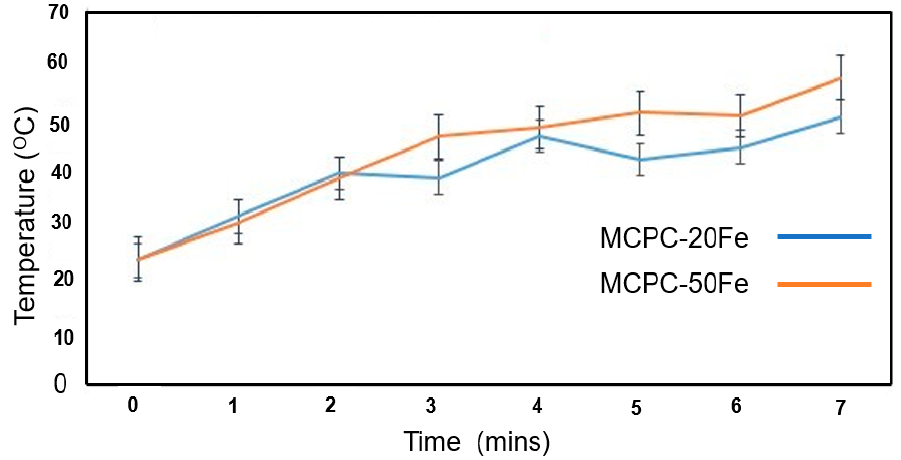
Figure 2. Heat generation profile of MCPC with different concentrations of magnetite. MCPC indicates magnetic calcium phosphate cement, and Fe indicates magnetite incorporation.